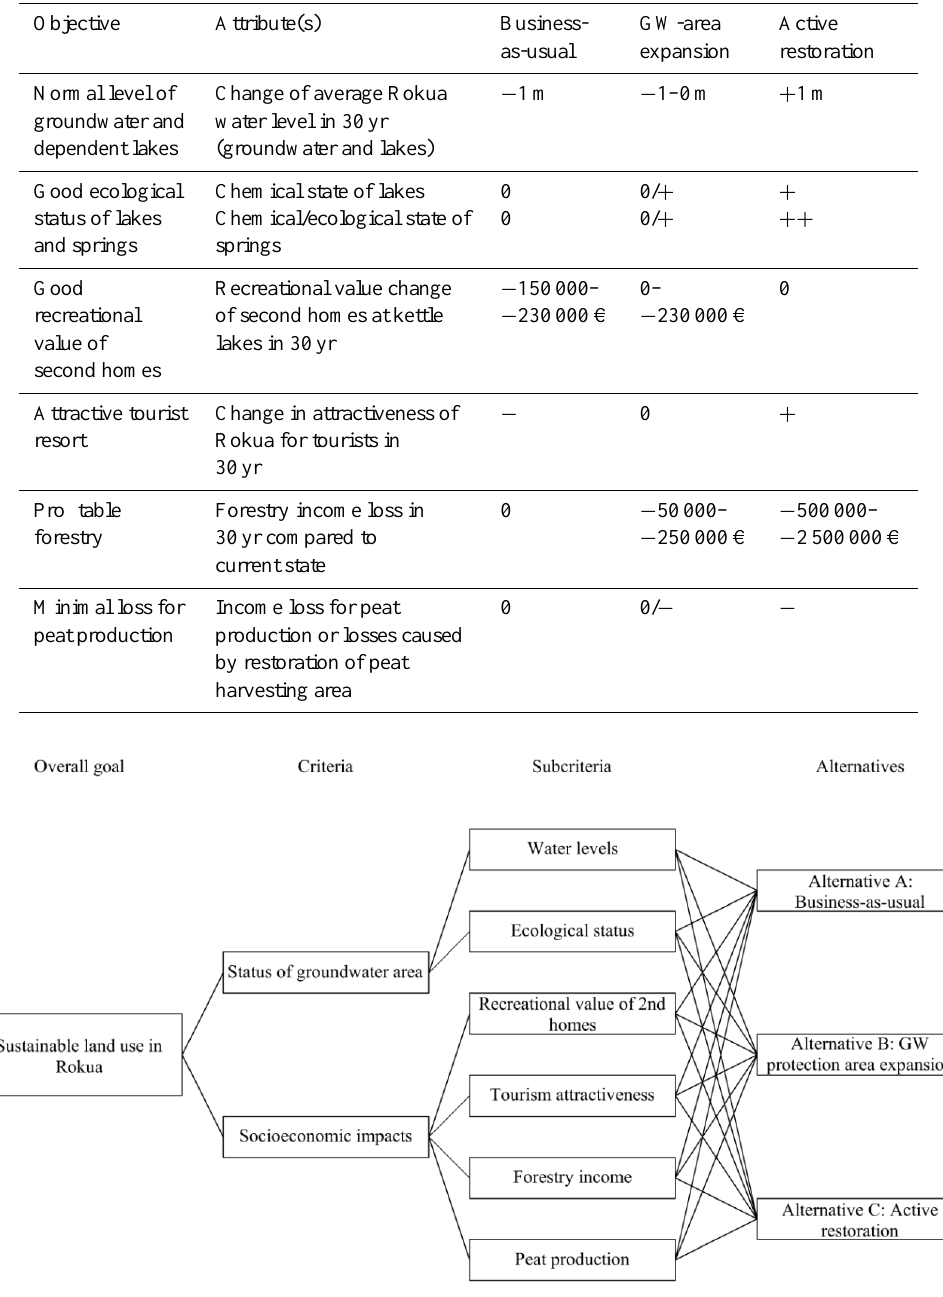
Table 2. Objectives, attributes and impact matrix of the different alternatives.